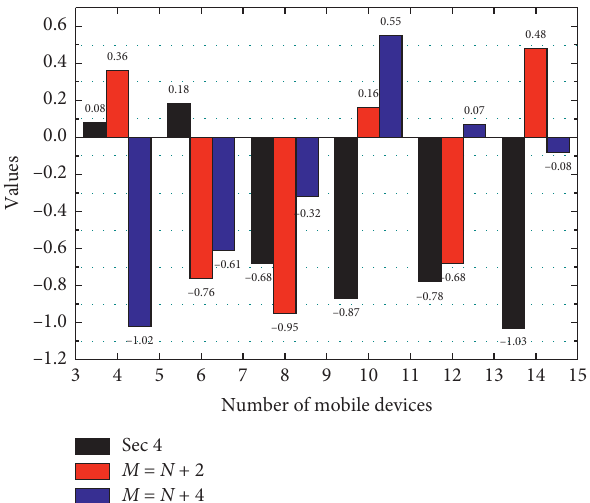
Figure 6: Comparison of average energy consumption of the VE- MACN